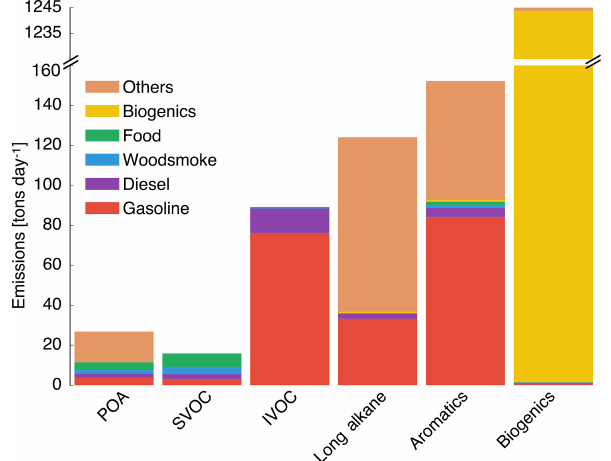
Figure 1. Episode-averaged gas- and particle-phase organic emis- sions in metric tons per day over the 8km southern California do- main resolved by source. POA and SVOC represent the particle- and gas-phase emissions partitioned to an OA mass concentration of 9µgm − 3 . SVOC, IVOC, long alkanes, aromatics, and biogenics represent gas-phase emissions of precursor species that are modeled to form SOA. We note that recent measurements suggest that POA from food cooking sources is less volatile than assumed in these